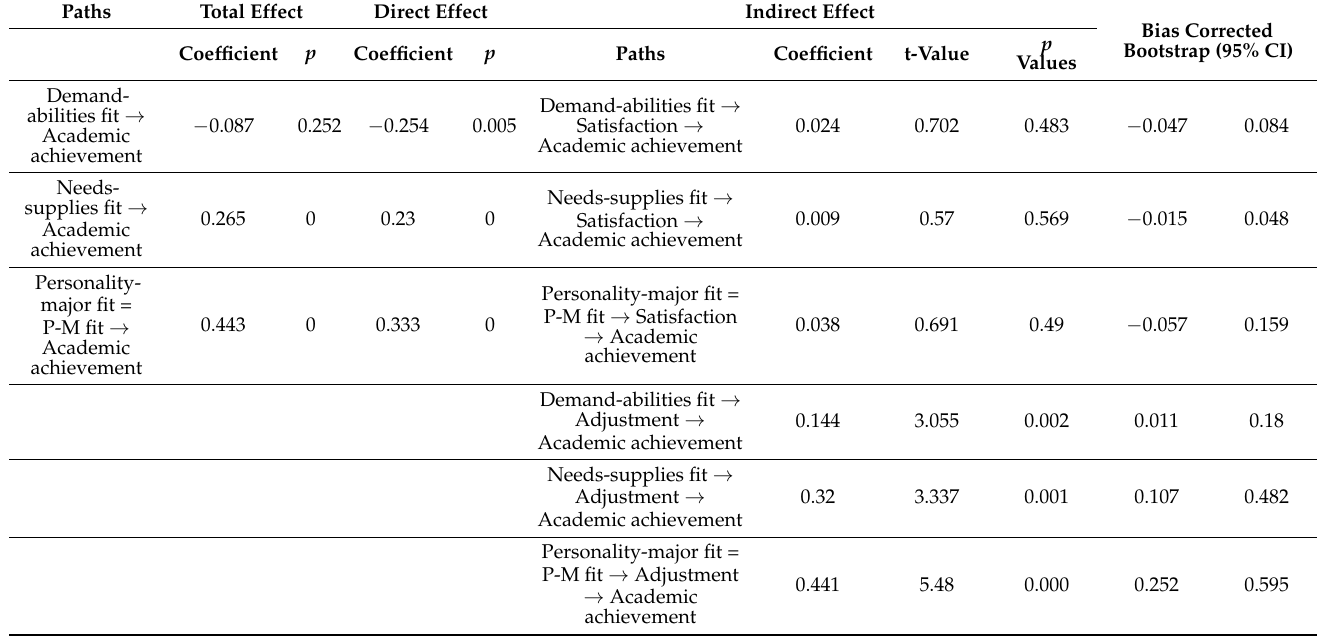
Table 3. Mediation